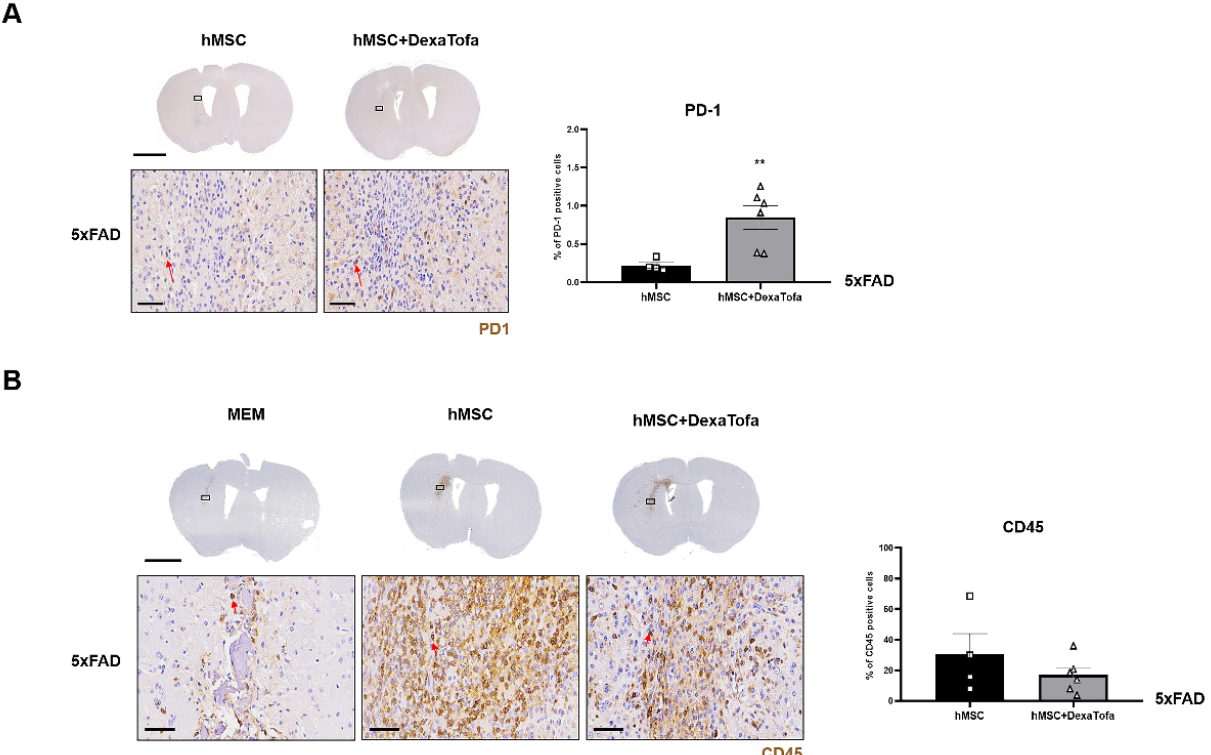
Figure 3. Combined administrations of dexamethasone and tofacitinib reduced PD-1 expression. ( A ) Representative images of PD-1 positive cells (solid red arrows) in the left hemisphere of hMSC ( n = 4) and hMSC + DexaTofa ( n = 6) groups. Higher PD-1 expression is evident from the hMSC + DexaTofa group. Statistical significance was defined as ** p < 0.01 vs. hMSC; mean ± SEM (unpaired t-test). Scale bars: whole brain = 2 mm, magnified inset area (solid black box) = 60 µm. ( B ) Representative images of CD45-positive leukocytes (dark brown precipitate, solid red arrows) for the MEM ( n = 3), hMSC ( n = 4), and hMSC + DexaTofa ( n = 6) groups. Compared to the hMSC group, the hMSC + DexaTofa group displayed reduced levels of CD45-positive leukocytes. Scale bars: whole brain = 2 mm, magnified inset area = 60 µm. Values are expressed as mean ± SEM.